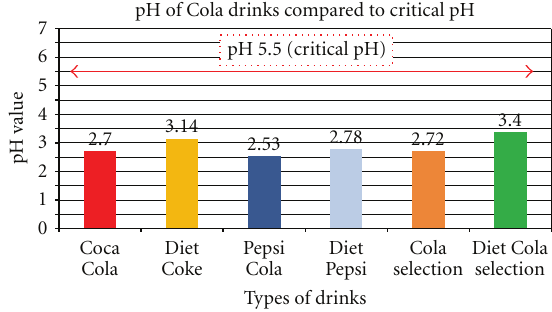
Figure 1: pH comparison among pop-Cola drinks. The pH levels of the six analyzed cola drinks are all significantly below the critical pH (pH 5.5) of Calcium hydroxyapatite ( P < . 001 Student- t ). The diet colas are not necessarily more acidic; regular Pepsi Cola has the lowest pH (pH 2.53), while Diet Selection Cola is the highest pH (pH